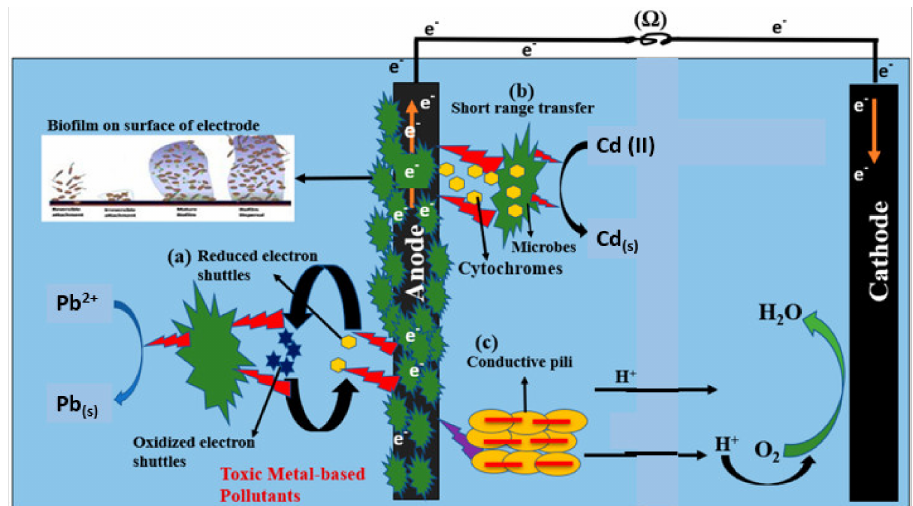
Figure 8. Mechanism of this research of BMFC (modified from reference [45], MDPI, an open-access